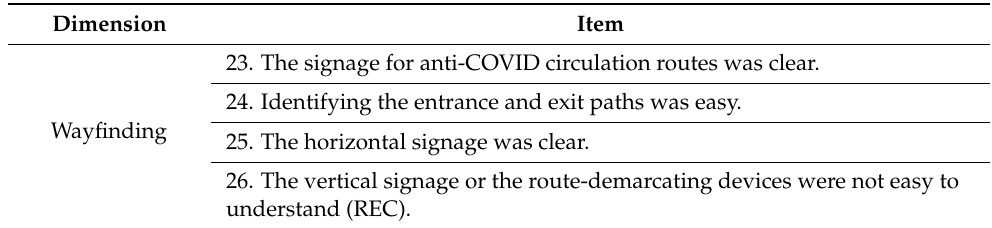
Table 7. Items of the case study questionnaire specifically concerning the wayfinding system. Own